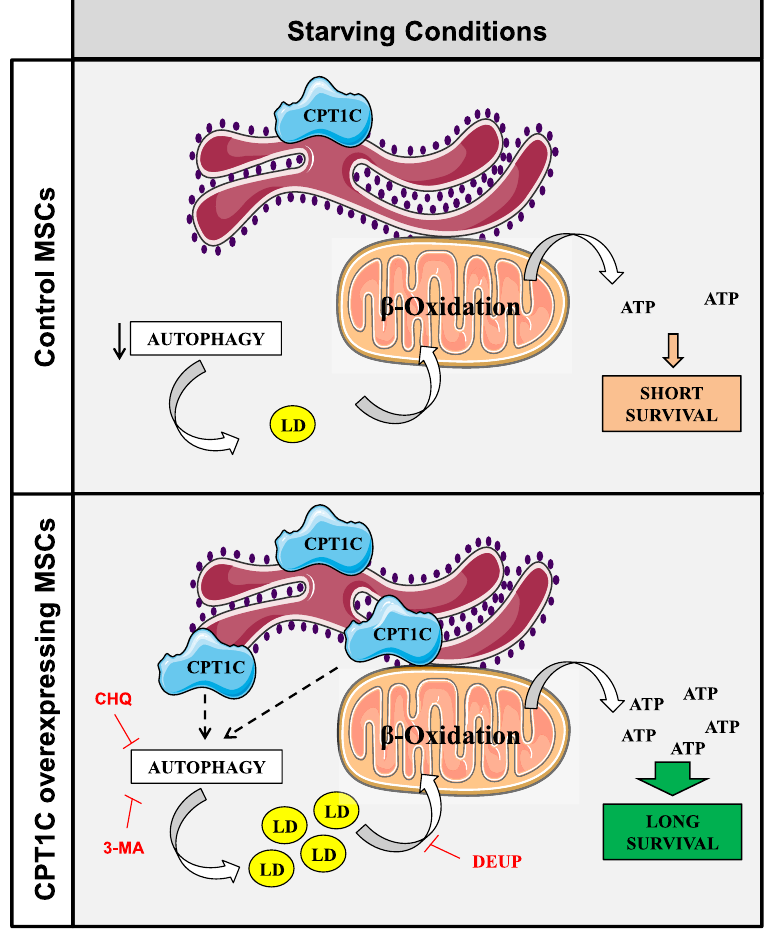
Figure 7. The suggested mechanism by which CPT1C increases cell survival in hMSCs under glucose starvation. hMSCs show reduced autophagic flux under glucose starvation. CPT1C overexpression increases autophagy and LD number in glucose-deficient conditions, which results in increased fatty acid availability for mitochondrial β -oxidation, and consequently, higher levels of ATP and longer cell survival compared to control